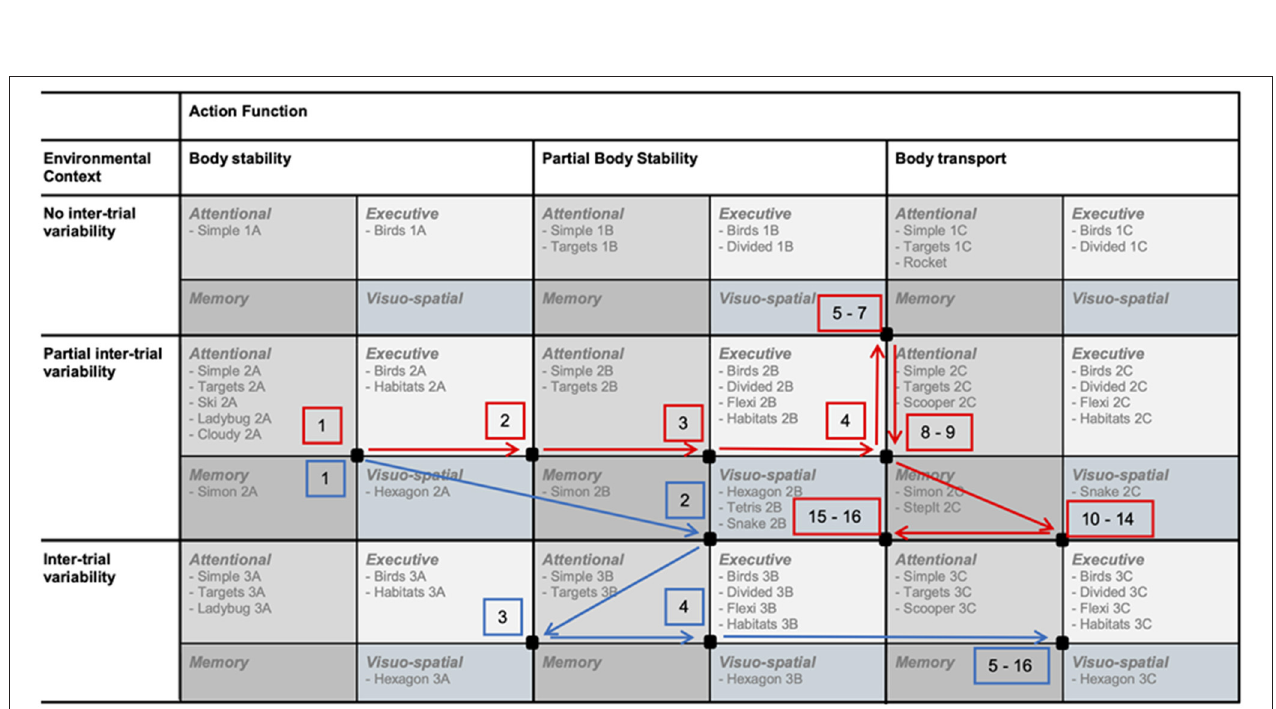
FIGURE 7 | Trajectories of two participants (red, blue) showing their “path” through the taxonomy from the first to the sixteenth training session. Black dots represent the center of the respective “position squares”.